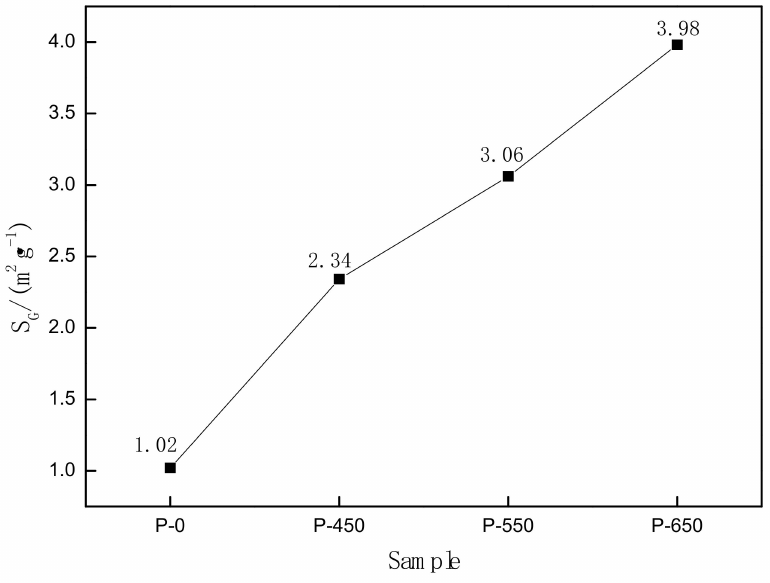
Figure 3. Relationship between specific surface area and